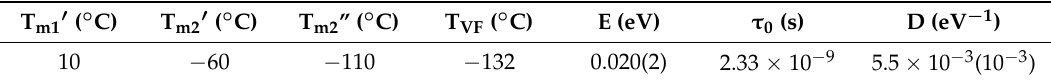
Table 1. The list of transition temperatures of the relaxor ferroelectric (FE) reentrant, the relaxor FE transition, and the coefficient of Vogel–Fulcher relation for PBZ50 ceramics. D is a constant obtained by fitting the hyperbolic tangent function to the observed dielectric